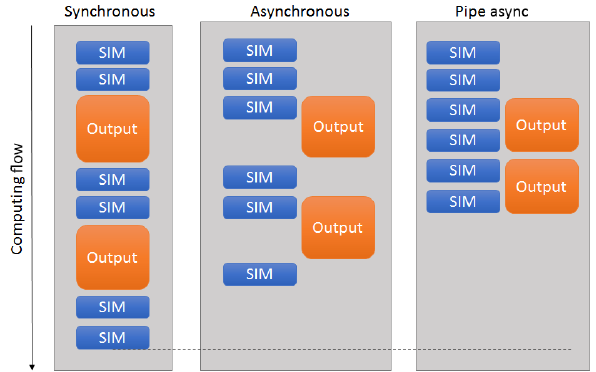
Figure 13. Output overlap and optimization using Pipe.